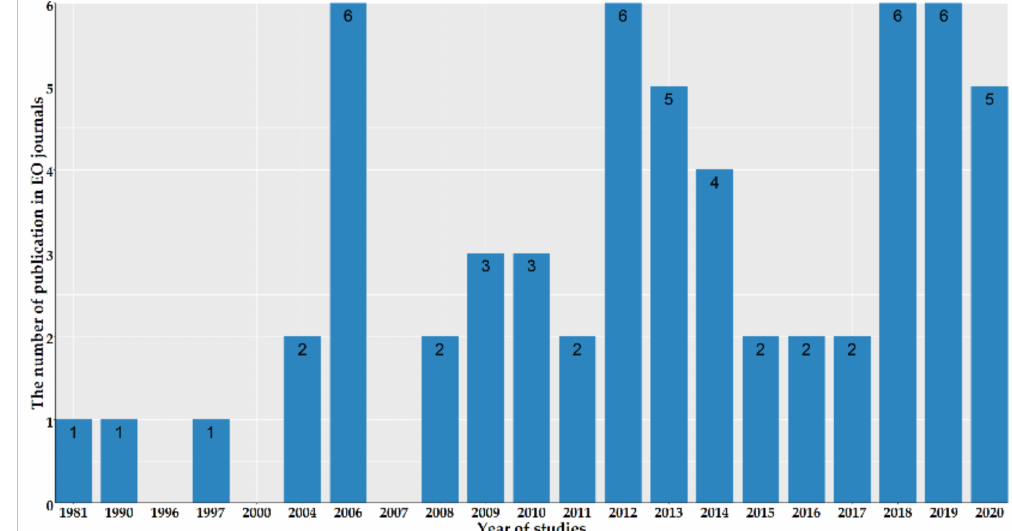
Figure 11. Temporal distribution of the analyzed publication of remote sensing and earth observation (EO) journals from 1981 to 2020.